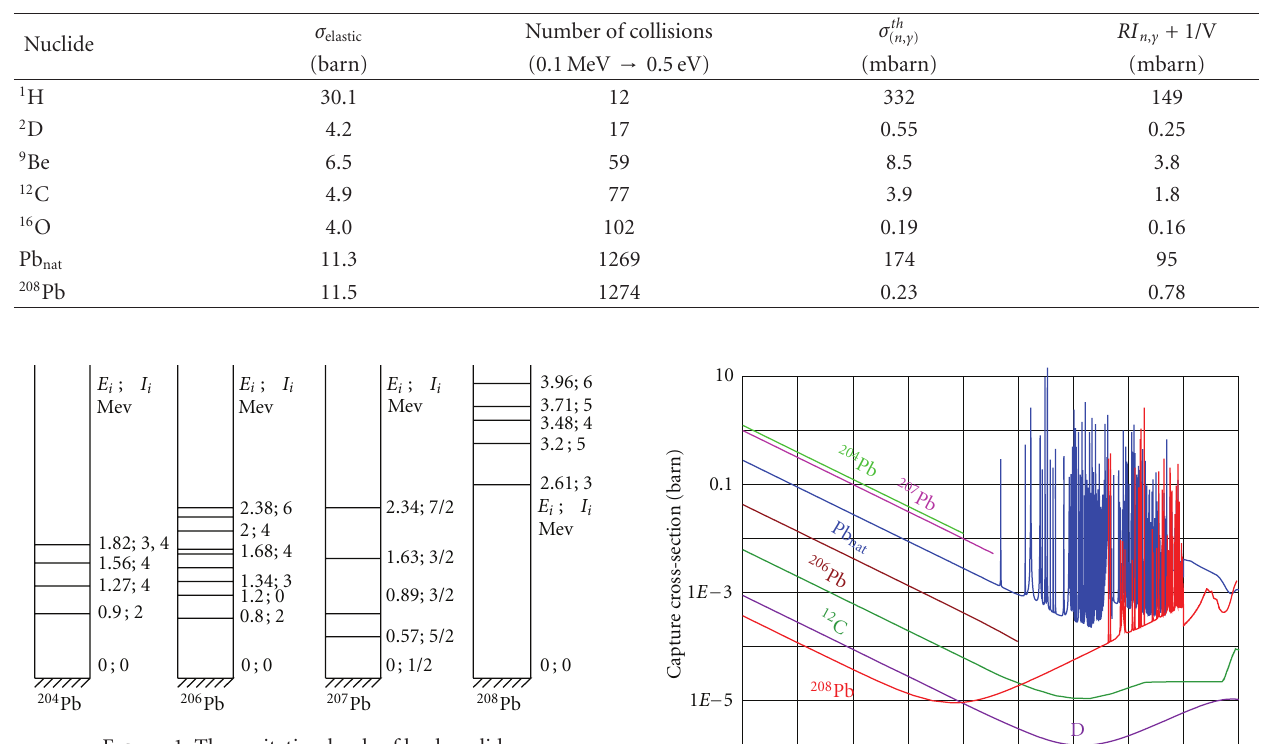
Table 1: Neutron-physical characteristics of some materials.